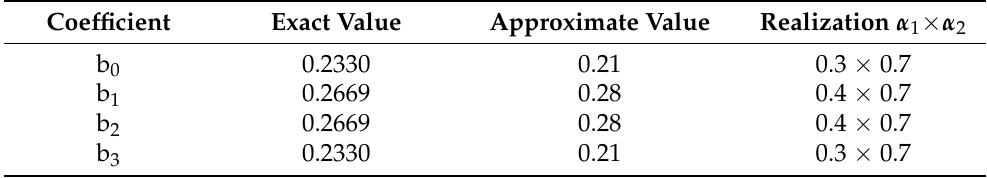
Figure 9. Implementation of 3rd order FIR filter with time-mode processing units. Table 1. FIR filter coefficient